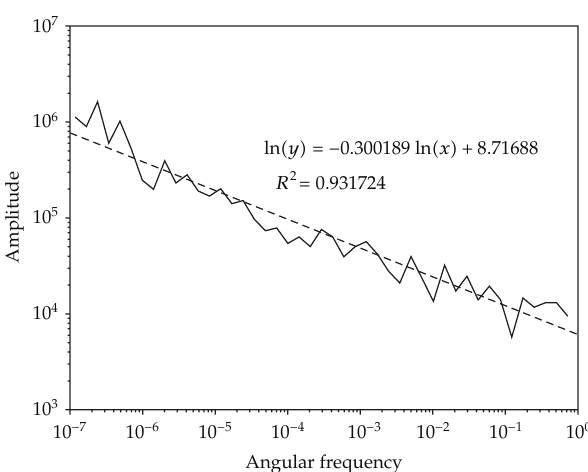
Figure 1: Amplitude of the Fourier transform versus frequency ω for chromosome 1 of the human being (cid:5) solid line (cid:6) and PL approximation (cid:5) dashed line (cid:6)